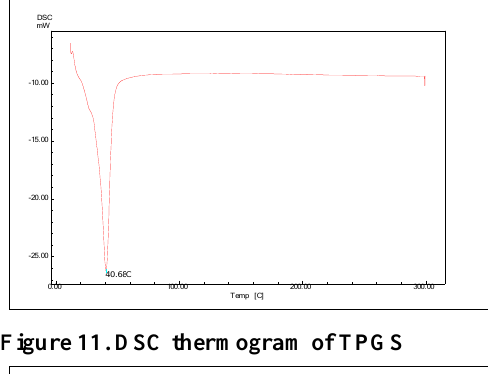
Figure 9. FTIR spectrum of selected formula of rem-TPGS (SD30) Differential scanning calorimeter (DSC)